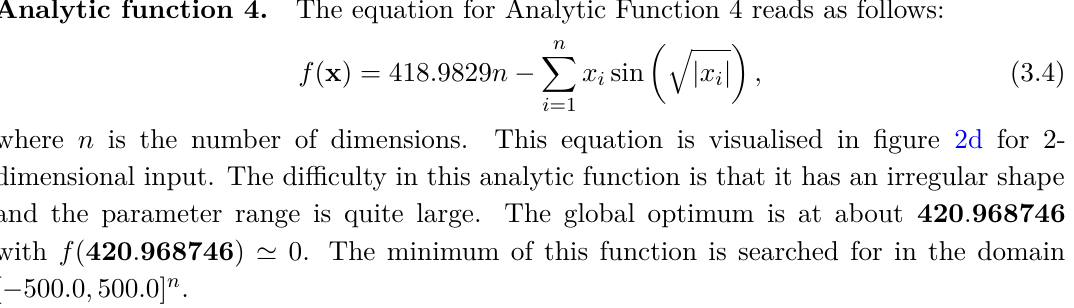
Figure 2. Visualisation of the explored analytic functions from section 3.1 in 2-dimensional form. Analytic function